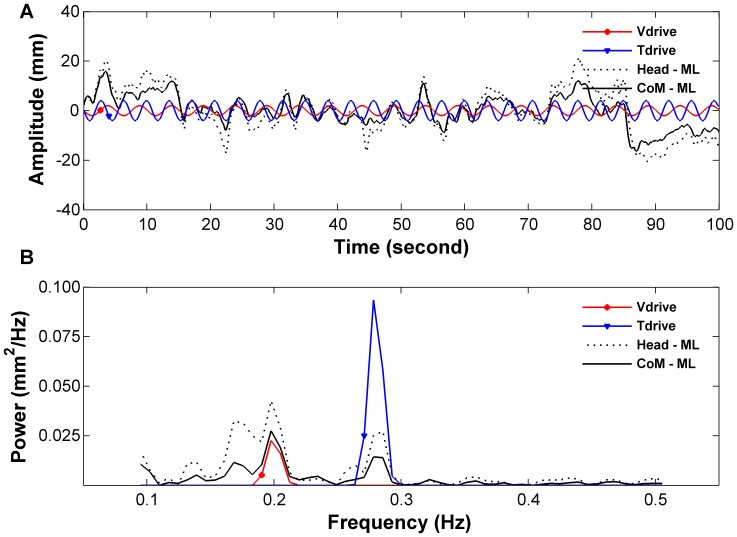
Exemplar of drives and sway from a T4V2 trial of a child with DCD.Subplot A shows the time series of the trajectories, and subplot B shows their power spectrum in the frequency domain. Note that the Tdrive and Vdrive oscillated at different frequency (0.28 and 0.2 Hz respectively).